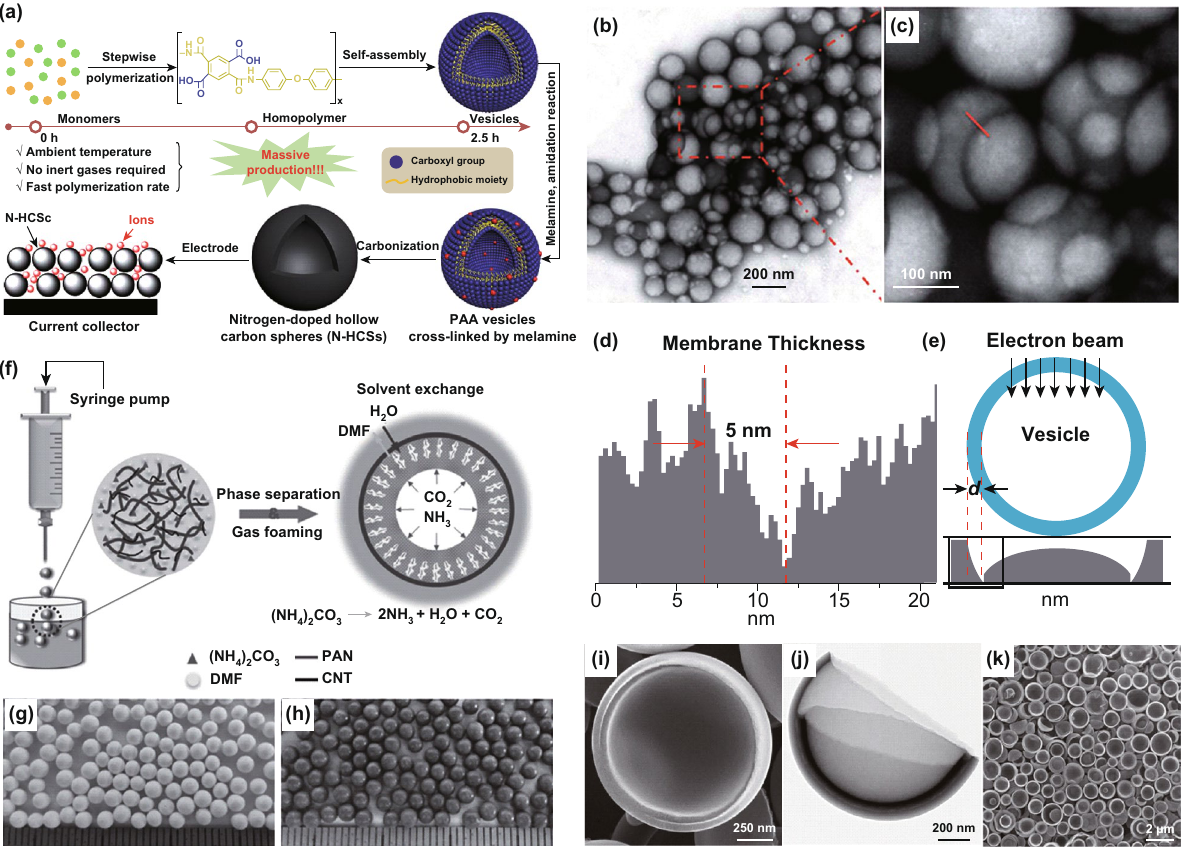
Fig. 5 a Formation of N-HCSs by homopolymers, self-assembly, and carbonization processes. b , c TEM images of PAA vesicles with some stack-up vesicles. d Electron transmittance chart related to the red scan line in b , e Electron transmittance simulation of hollow spheres. Repro- duced with permission from Ref. [77]. Copyright 2016, Royal Society of Chemistry. f Schematic illustration of the preparation of hollow poly- mer spheres. Photographs of g hollow polymeric PAN spheres, and h CNTs-reinforced hollow polymeric spheres. Reproduced with permission from Ref. [82]. Copyright 2016, Wiley–VCH. i SEM and j TEM images of the porous carbon double-hemispheres. k Low-magnification SEM image of a monolayer of the carbon double-hemispheres. Reproduced with permission from Ref. [83]. Copyright 2012,